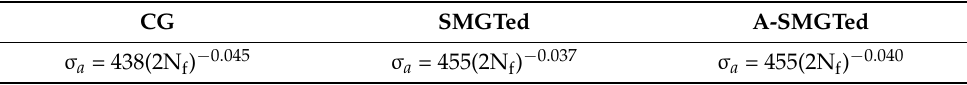
where σ a is the equivalent stress amplitude, (cid:1840) (cid:1858) is the fatigue life, (cid:2026)’ (cid:1858) is the fatigue strength coefficient, and b is the fatigue strength exponent (Basquin exponent). The tions are found for the CG Zr-4, SMGTed Zr-4, and A-SMGTed Zr-4 alloys, and obtained by Basquin equations are found for the CG Zr-4, SMGTed Zr-4, and A-SMGTed Zr-4 alloys, linear fitting of fatigue data in Figure 3, as shown in Table 2. and obtained by linear fitting of fatigue data in Figure 3, as shown in Table 2. Table 2. The Basquin equations for CG, SMGTed, and A-SMGTed Zr-4 alloys. Table 2. The Basquin equations for CG, SMGTed, and A-SMGTed Zr-4 alloys. CG SMGTed CG SMGTed A-SMGTed